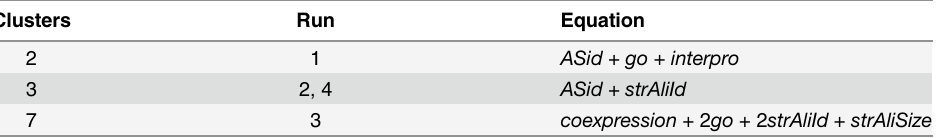
Table 8. Data combinations which yielded the best results for the protein kinases in five runs of the GP system. Clusters